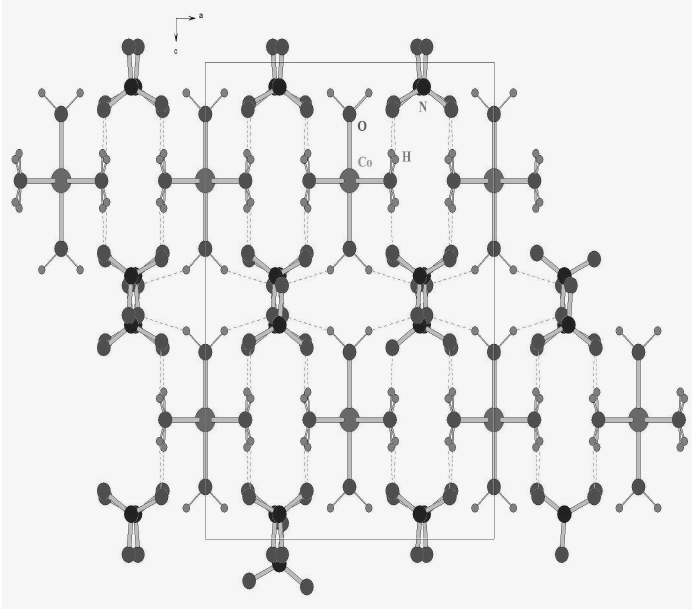
Figure 1. Asymmetric unit of Co(H probability displacement ellipsoids for non- H atoms.